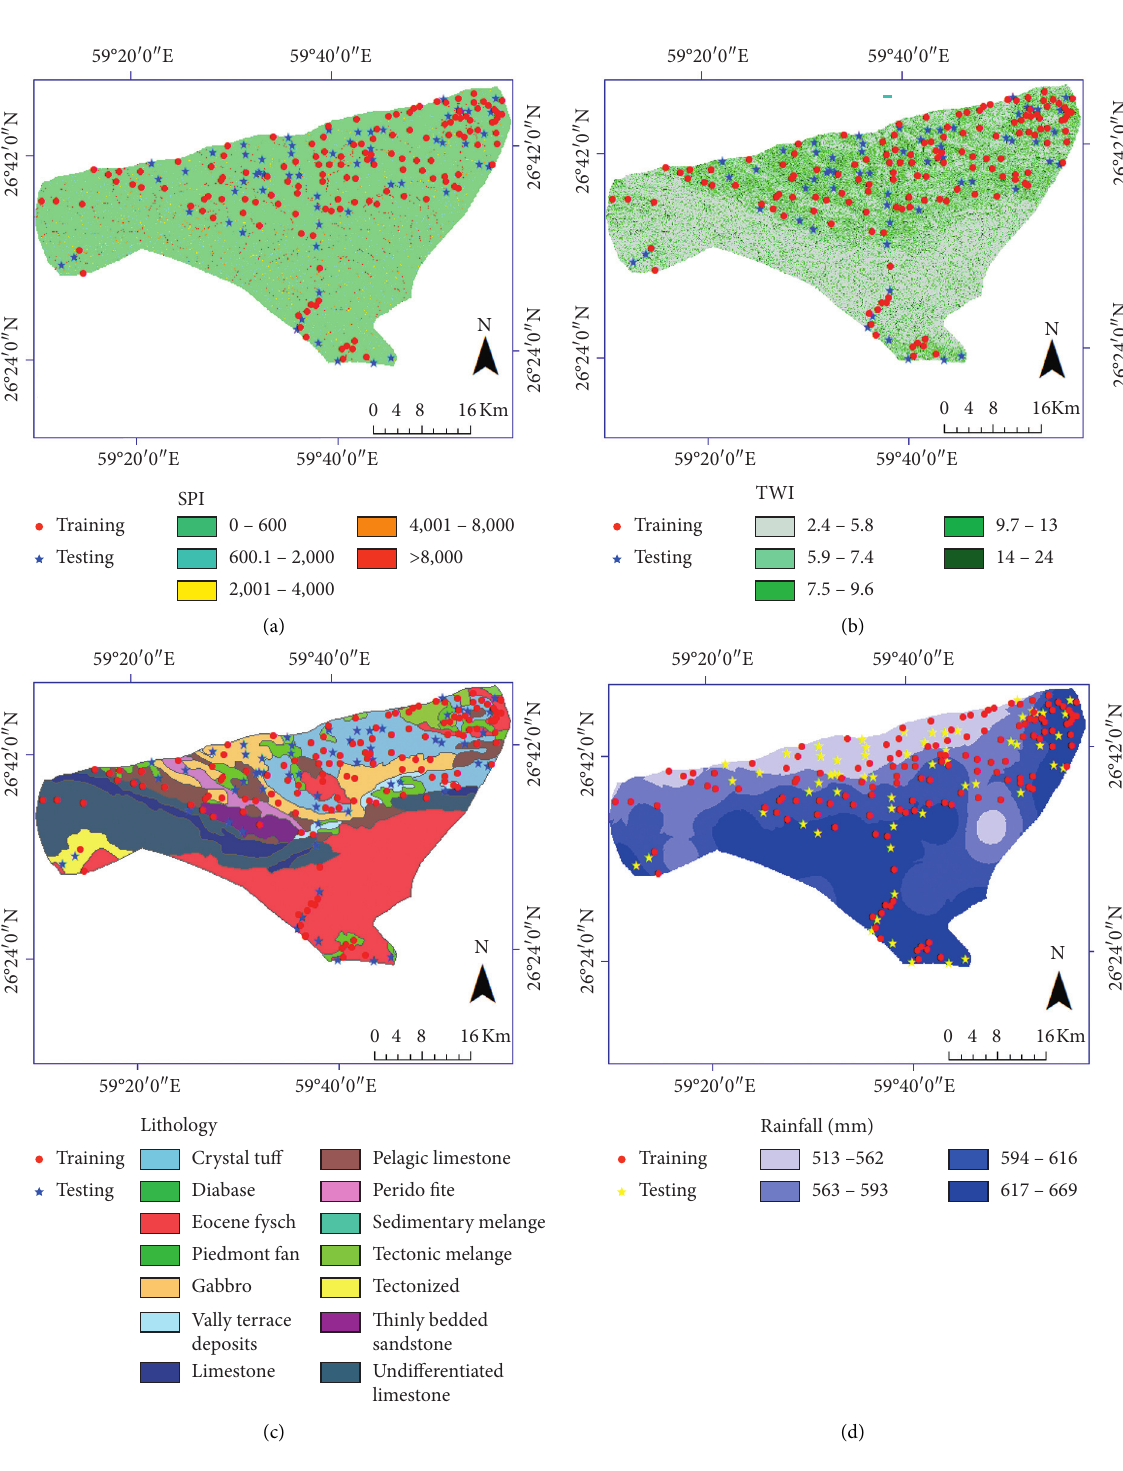
Figure 5: (a) SPI. (b) TWI. (c) Lithology. (d)